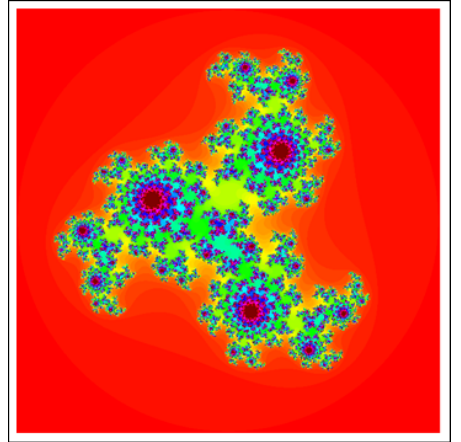
Figure 2. Third degree J-set via F-iteration with visualization period = 53.8